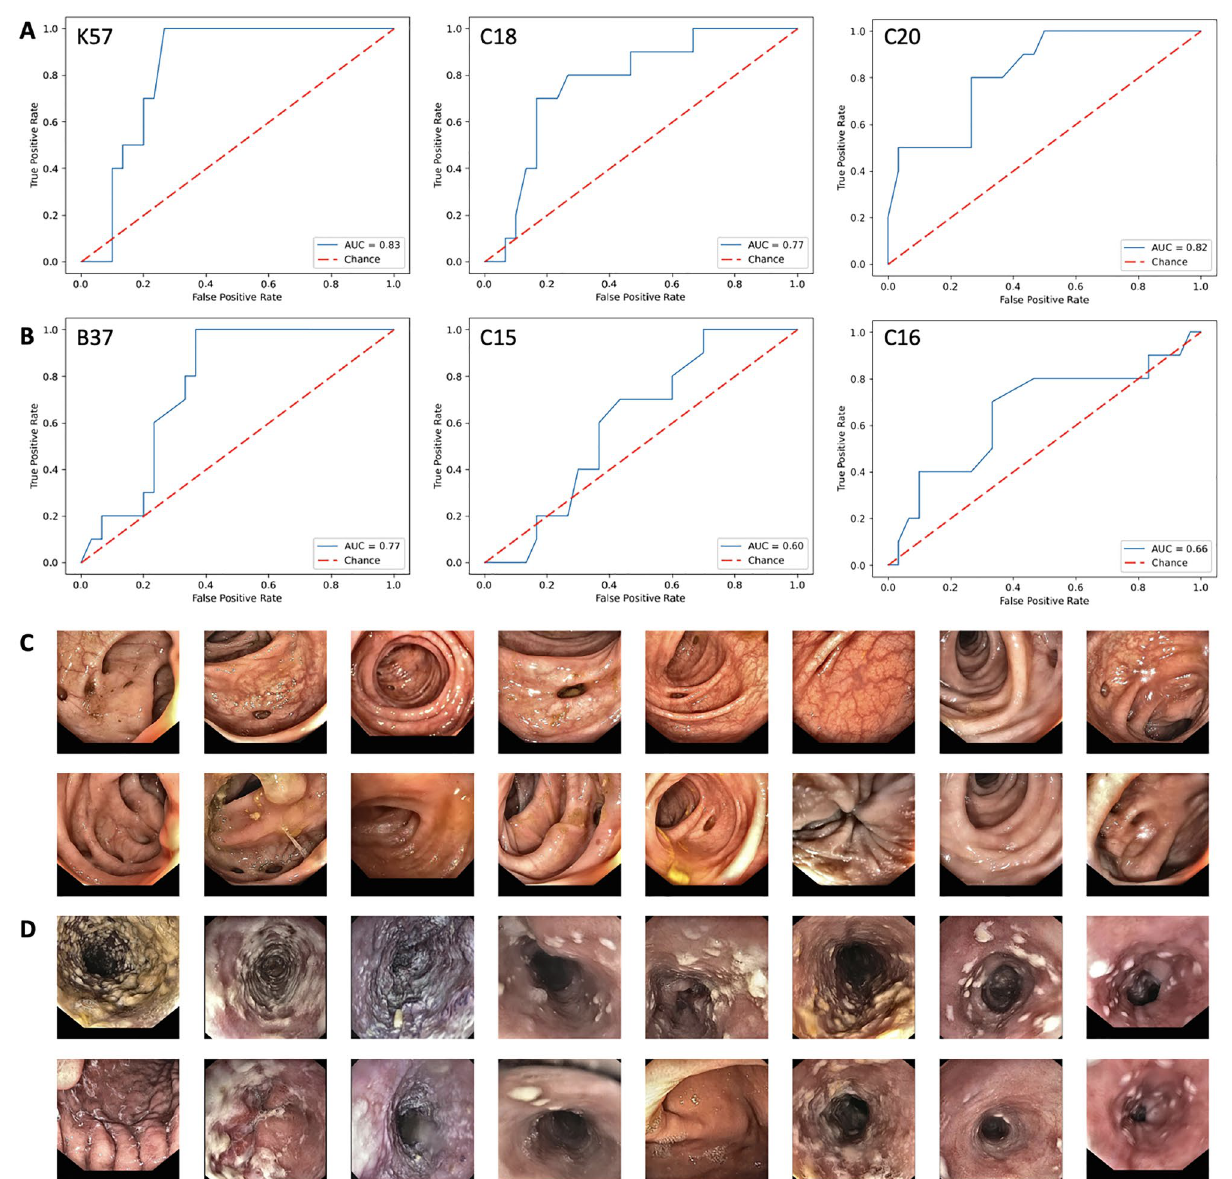
Figure 5. Classification performance in the external validation set. ( A ) Receiver operating curves (ROC) with area under the curve (AUC) in the colonoscopy validation set for K57 (diverticulosis), C18 (colon cancer) and C20 (rectal cancer). ( B ) ROC in the gastroscopy validation set for B37 (candidiasis), C15 (esophageal cancer) and C16 (gastric cancer). ( C ) Highest scoring images (two each) in highest scoring patients (eight) as selected by the AI model from the validation set for K57 (diverticulosis) ( D ) and B37